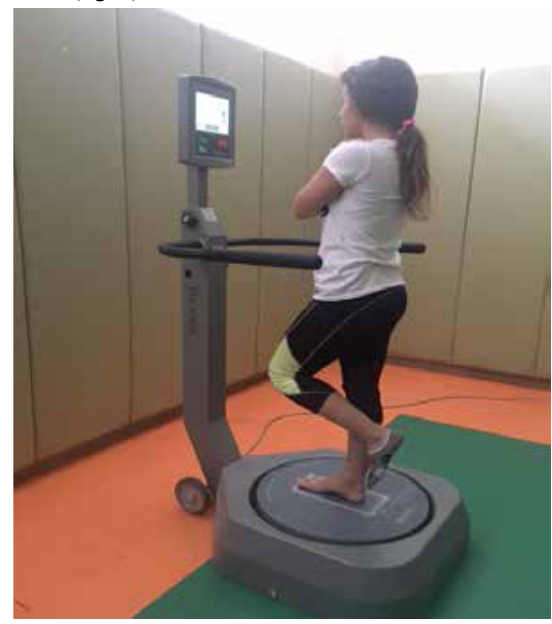
Figure 1. The measurement of postural